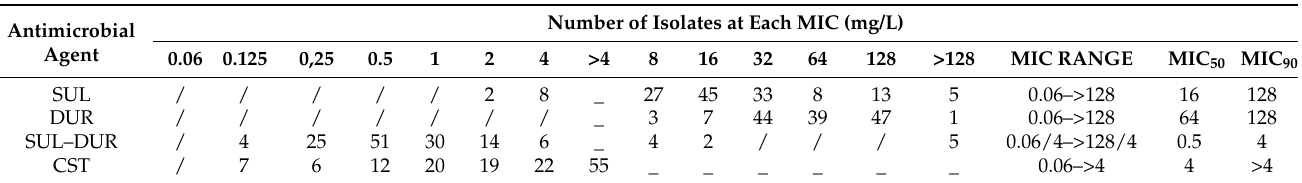
Table 1. In vitro activities of sulbactam–durlobactam and comparators against 141 carbapenem- resistant Acinetobacter baumannii collected in Italy.